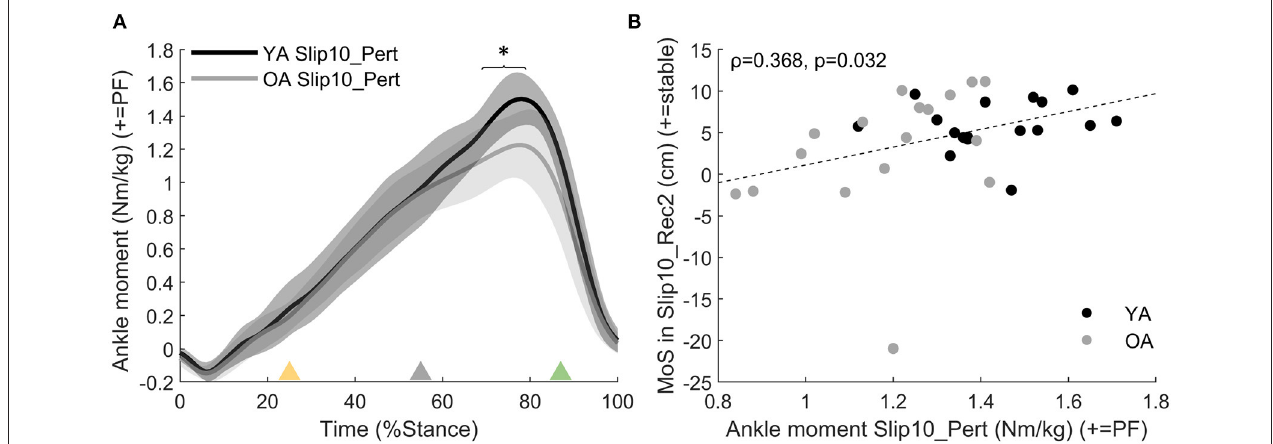
FIGURE 6 | (A) Ankle moment age difference between YAs and OAs for Slip10_Pert. Solid black line: YA in Slip10_Pert; solid grey line: OA in Slip10_Pert. *: significant effect of Age ( p = 0.004 from 69 to 79% stance). Yellow triangle: beginning of belt acceleration; grey triangle: peak belt speed; green triangle: belt speed returns to 1.2